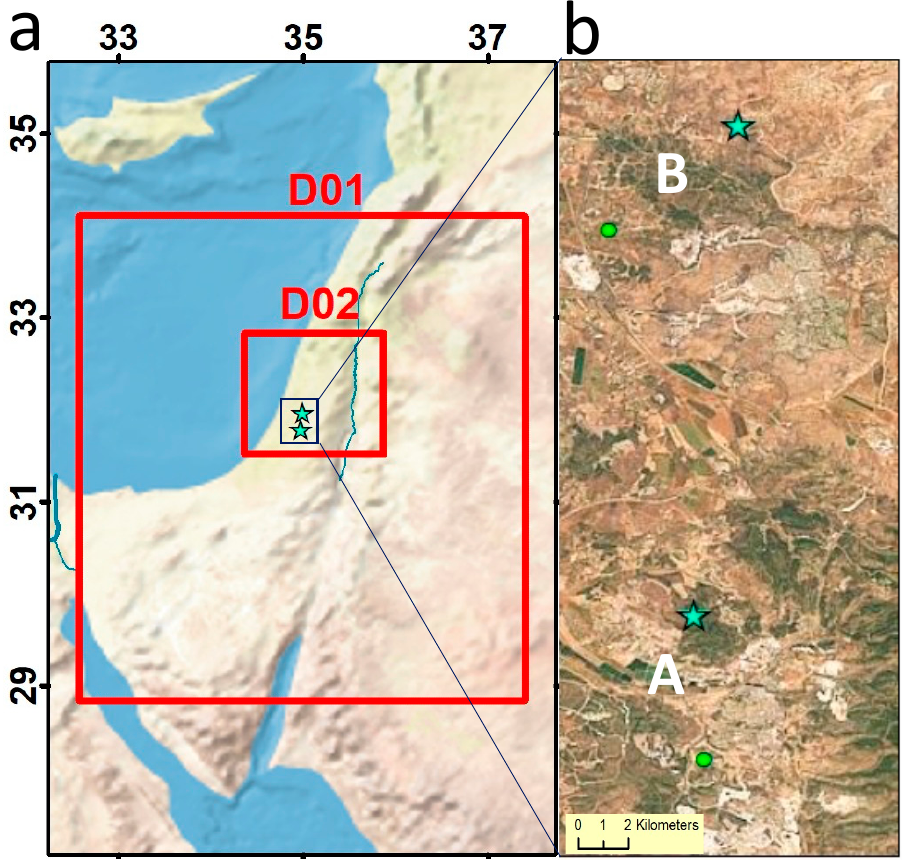
Figure 3. ( a ) The multi-scale WRF setup in this study (red boxes) D01 and D02 with horizontal grid spacings of 6000 m and 2000 m, respectively. The sub-grid resolution of the fire sub-model is of 200 m. ( b ) Locations of the two wildfires in central Israel (case A and B) are marked by the blue stars, and the locations of the meteorological stations by the green circles.